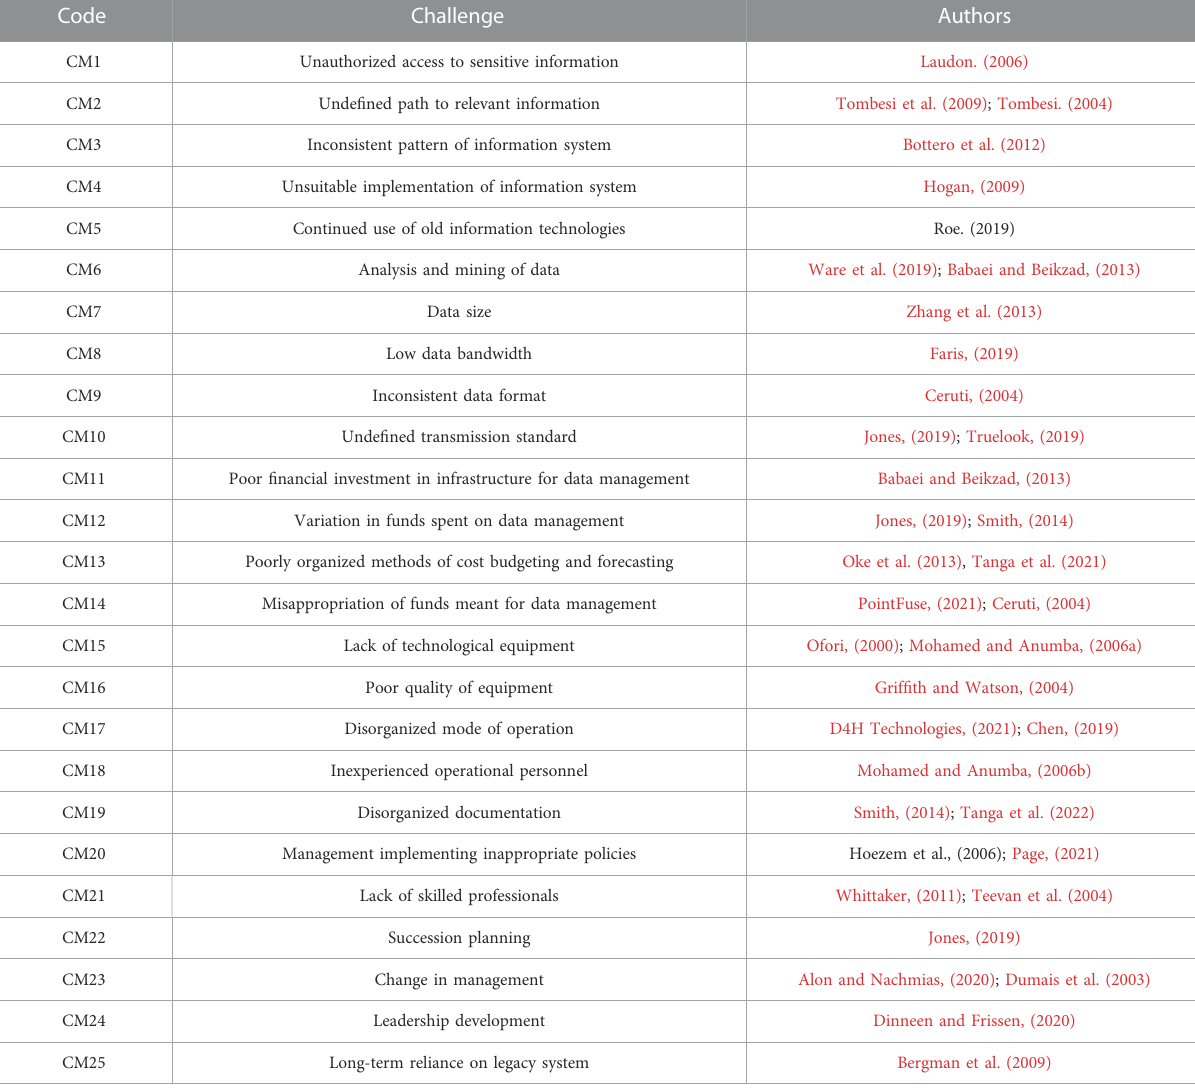
TABLE 1 List of challenges in construction information